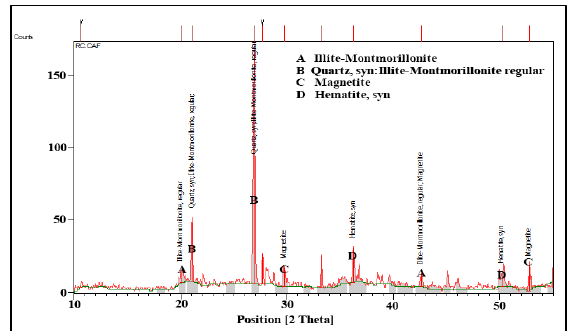
Figure 3: XRD pattern plot of residual clay, showing the various minerals. Table 3: Concentration of F- left in solution after treatment of raw water with various doses of Residual Clay and Termitaria Clay at different times.